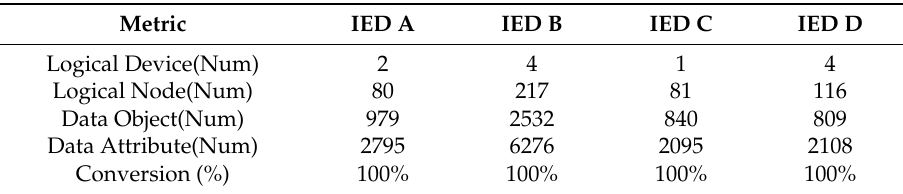
Table 6. The number of nodes for each data type and rate of conversion.